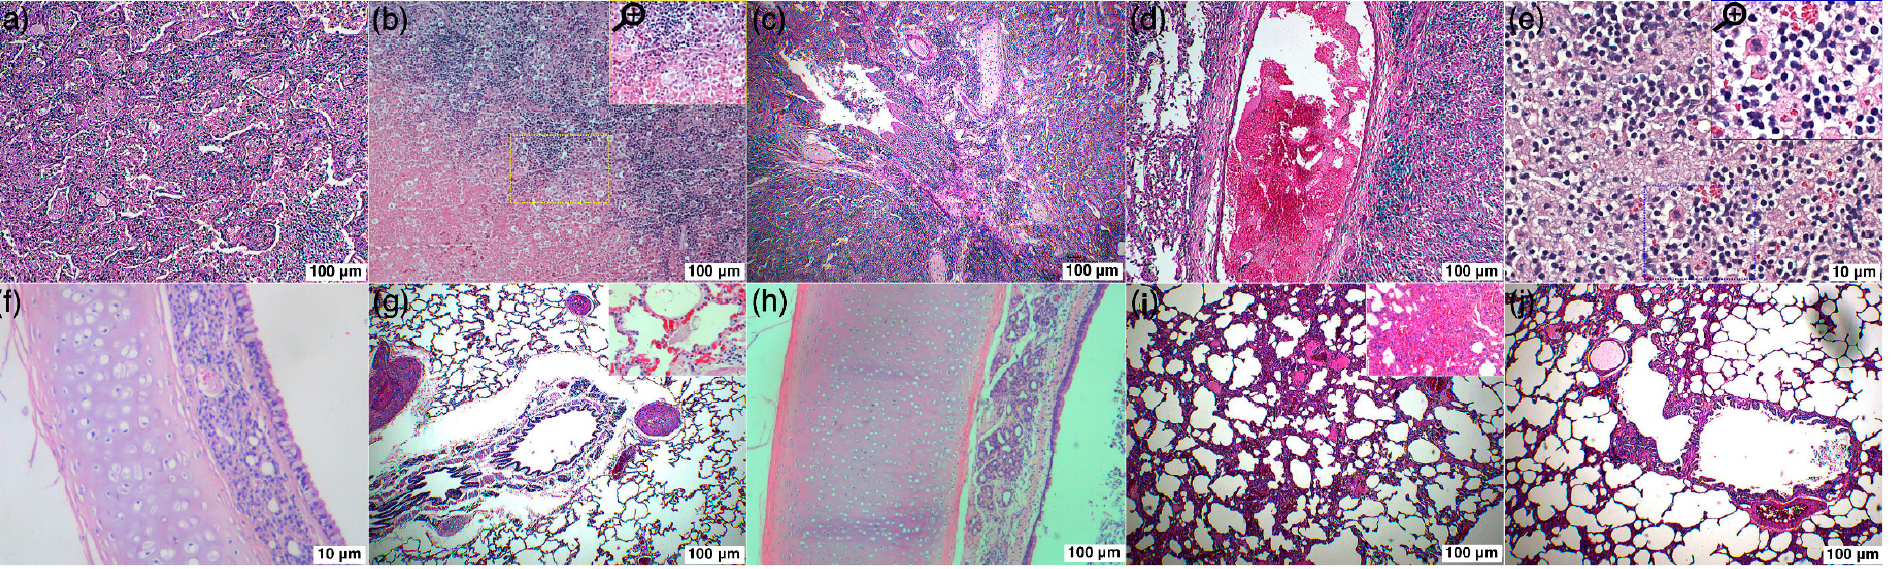
Figure 18. ( a – j ) Bronchopneumonia due to R. equi in Cat 25 ( a – e ). Cat 01 ( f,g ) positive for FCoV and FCV antibodies and Cat 02 ( h – j ) positive for FIV, FCoV, FCV and FHV antibodies were presented with acute/chronic infectious respiratory disease signs. K. pneumoniae was isolated from trachea of both cats. Photomicrograph ( a ) indicates severe infiltration of the mononuclear and polymorph inflammatory cells in alveolar spaces; ( b ) coagulative necrosis in lung tissue; ( c ) severe infiltration of the alveolar spaces with mononuclear inflammatory cells; bronchial lumen was infiltrated with inflammatory exudate, proteinaceous material and sloughed epithelial cells; necrosis and degeneration of the bronchial epithelium and severe infiltration of the peri-bronchial spaces with mononuclear inflammatory cells; ( d ) severely engorged arterial blood vessel with blood and necrosis and severe infiltration of the inflammatory cells in the surroundings; ( e ) severe infiltration of the alveolar spaces with mononuclear inflammatory cells especially macrophages and lymphocytes highlighted in magnified area; ( f ) normal trachea ( g ) relatively normal bronchus and alveolar spaces with congested blood vessels in surrounding and the highlighted area at the upper right corner shows acute congestion (mild) of the lung tissue being examined at higher magnification; ( h ) normal trachea with mildly sloughed epithelial cells in tracheal lumen; ( i ) severely congested and edematous alveolar walls and interstitial spaces; ( j ) relatively normal section of the lung tissue with mild congestion and edema of the alveolar walls and interstitial spaces. (H&E: Hematoxylin and Eosin; 40×–400×).